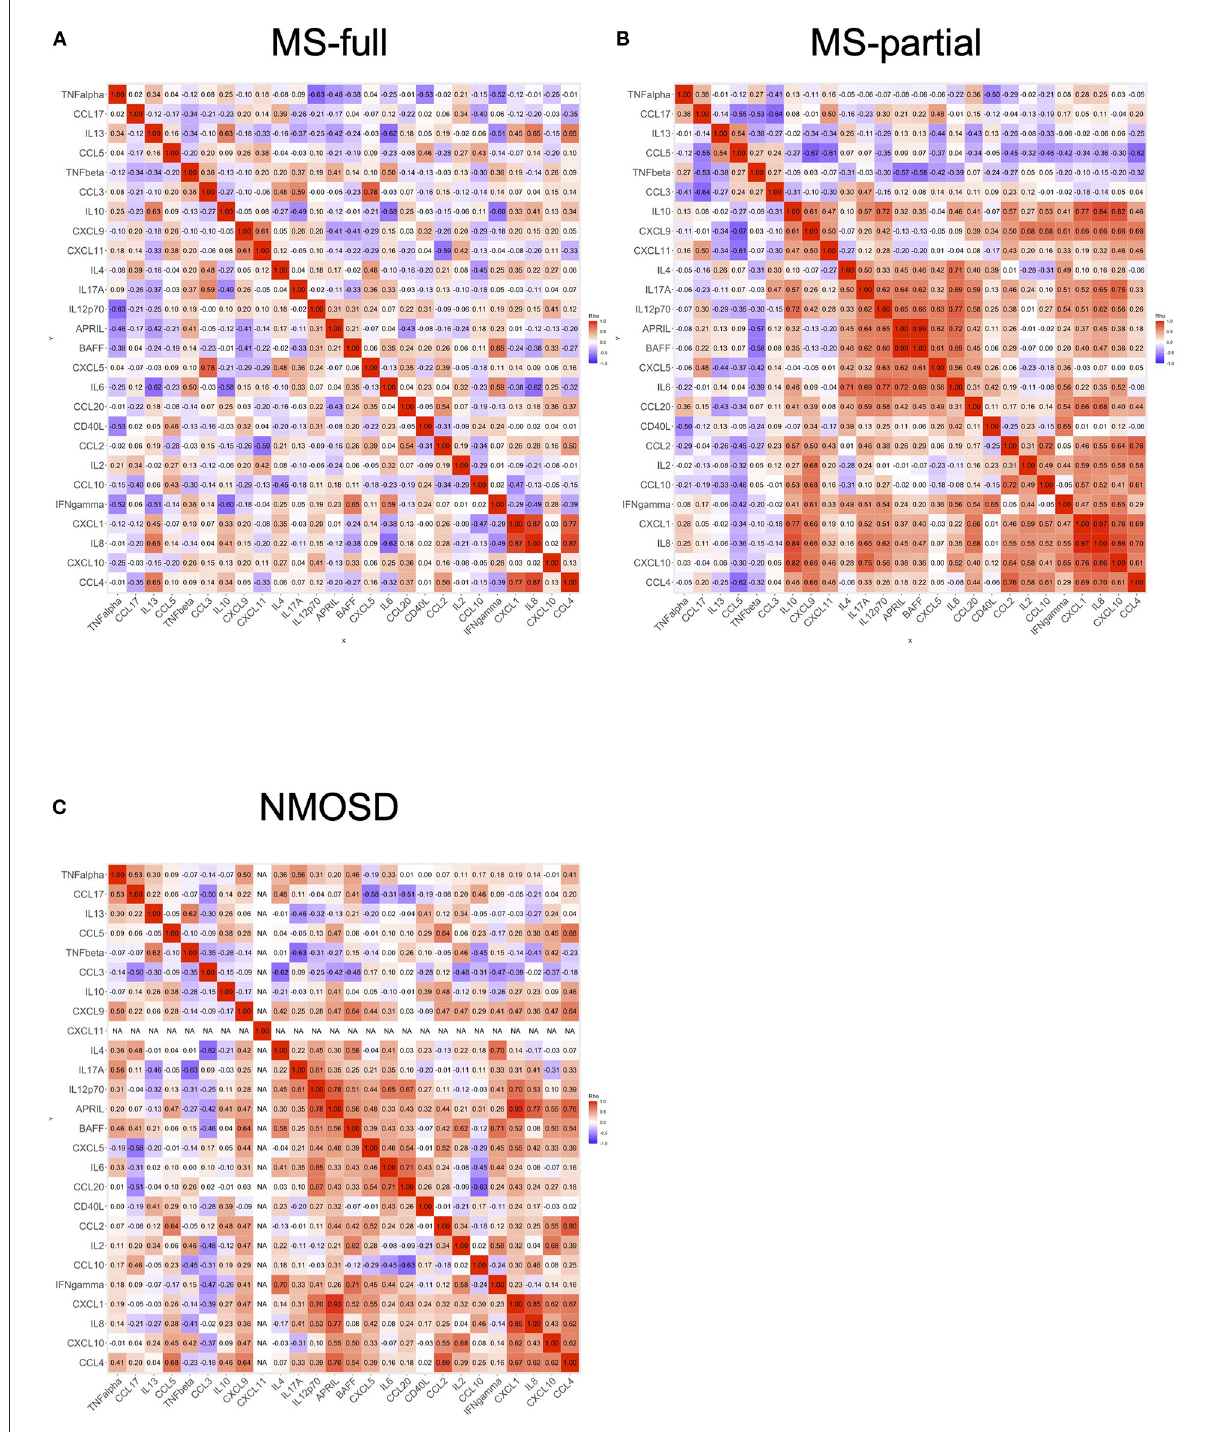
FIGURE3 Correlation of cytokine and chemokine levels in CSF. The correlation of cytokine and chemokine levels in all MS and NMOSD groups. Correlation rank was evaluated by Spearman’s rank correlation tests. Each heatmap showed the correlation between the levels of cytokines or chemokines: MS-full (A) , MS-partial (B) , and NMOSD (C) . CSF, cerebrospinal fluid; MS, multiple sclerosis; NMOSD, neuromyelitis optica spectrum